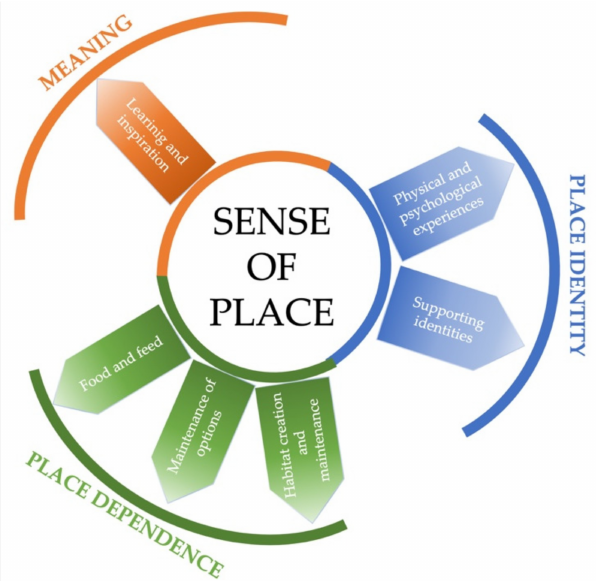
Figure 9. Characterization of the sense of place in the CCLC (adapted from Masterson et al.